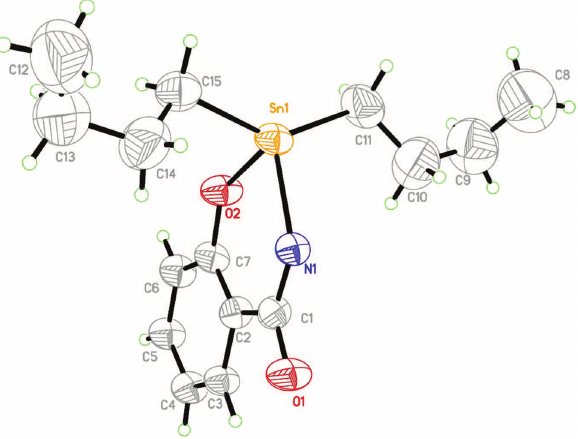
Figure 1: The molecule structure of the